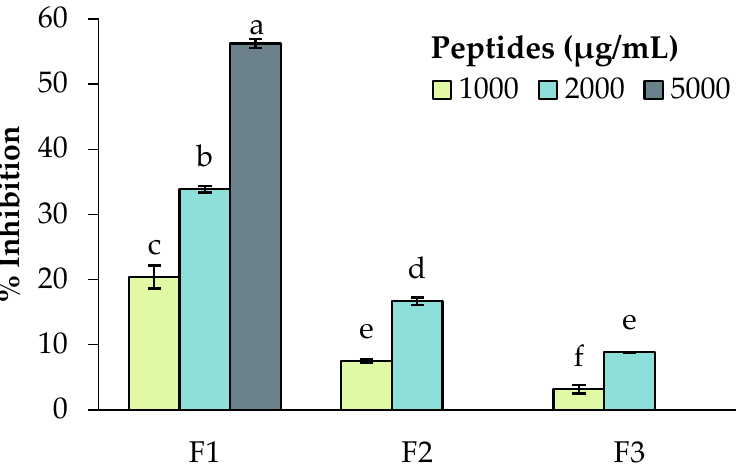
Figure 10. Angiotensin-Converting Enzyme inhibition of faba bean (variety Fabelle) peptide-enriched fractions (F1, F2 and F3). Data are expressed as mean ± standard deviation and means without a common letter differ ( p < 0.05) as analyzed by one-way ANOVA and the Tukey’s test. Table 3. Antioxidant activity of faba bean (variety Fabelle) peptide-enriched fractions (F1, F2 and F3).